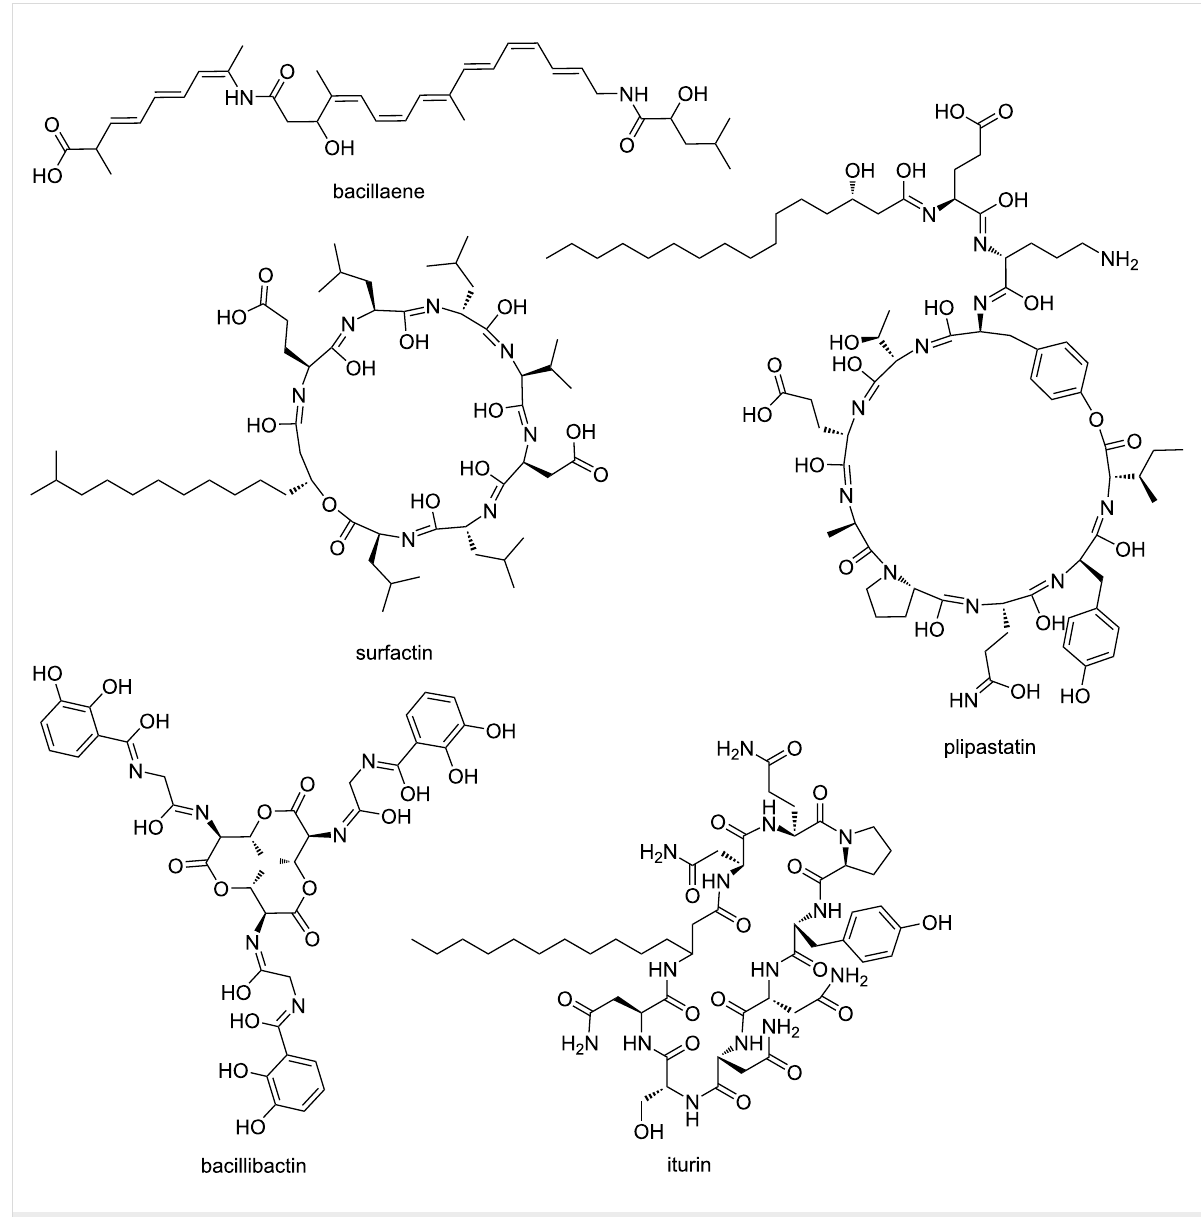
Figure 1: Overview of the NRPs surfactin, plipastatin, bacillibactin, and iturin as well as the hybrid NRP-PK bacillaene produced by Bacilli